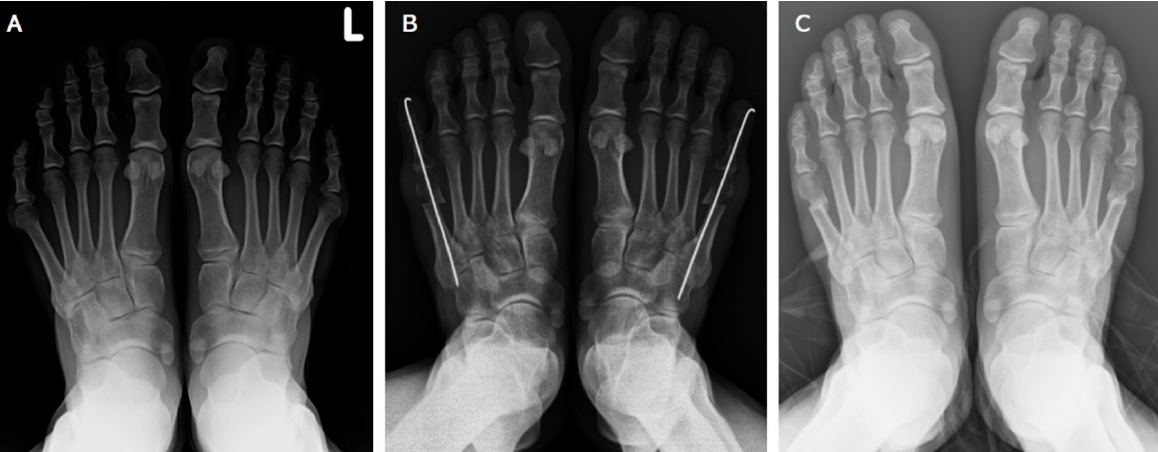
Figure 2. ( A ) Preoperative weightbearing anteroposterior radiographic image of both feet. ( B ) Anteroposterior radiographic image of both feet obtained immediately after the procedure. ( C ) Weightbearing anteroposterior radiographic image obtained 6 months after the procedure, showing bone union with good healing.